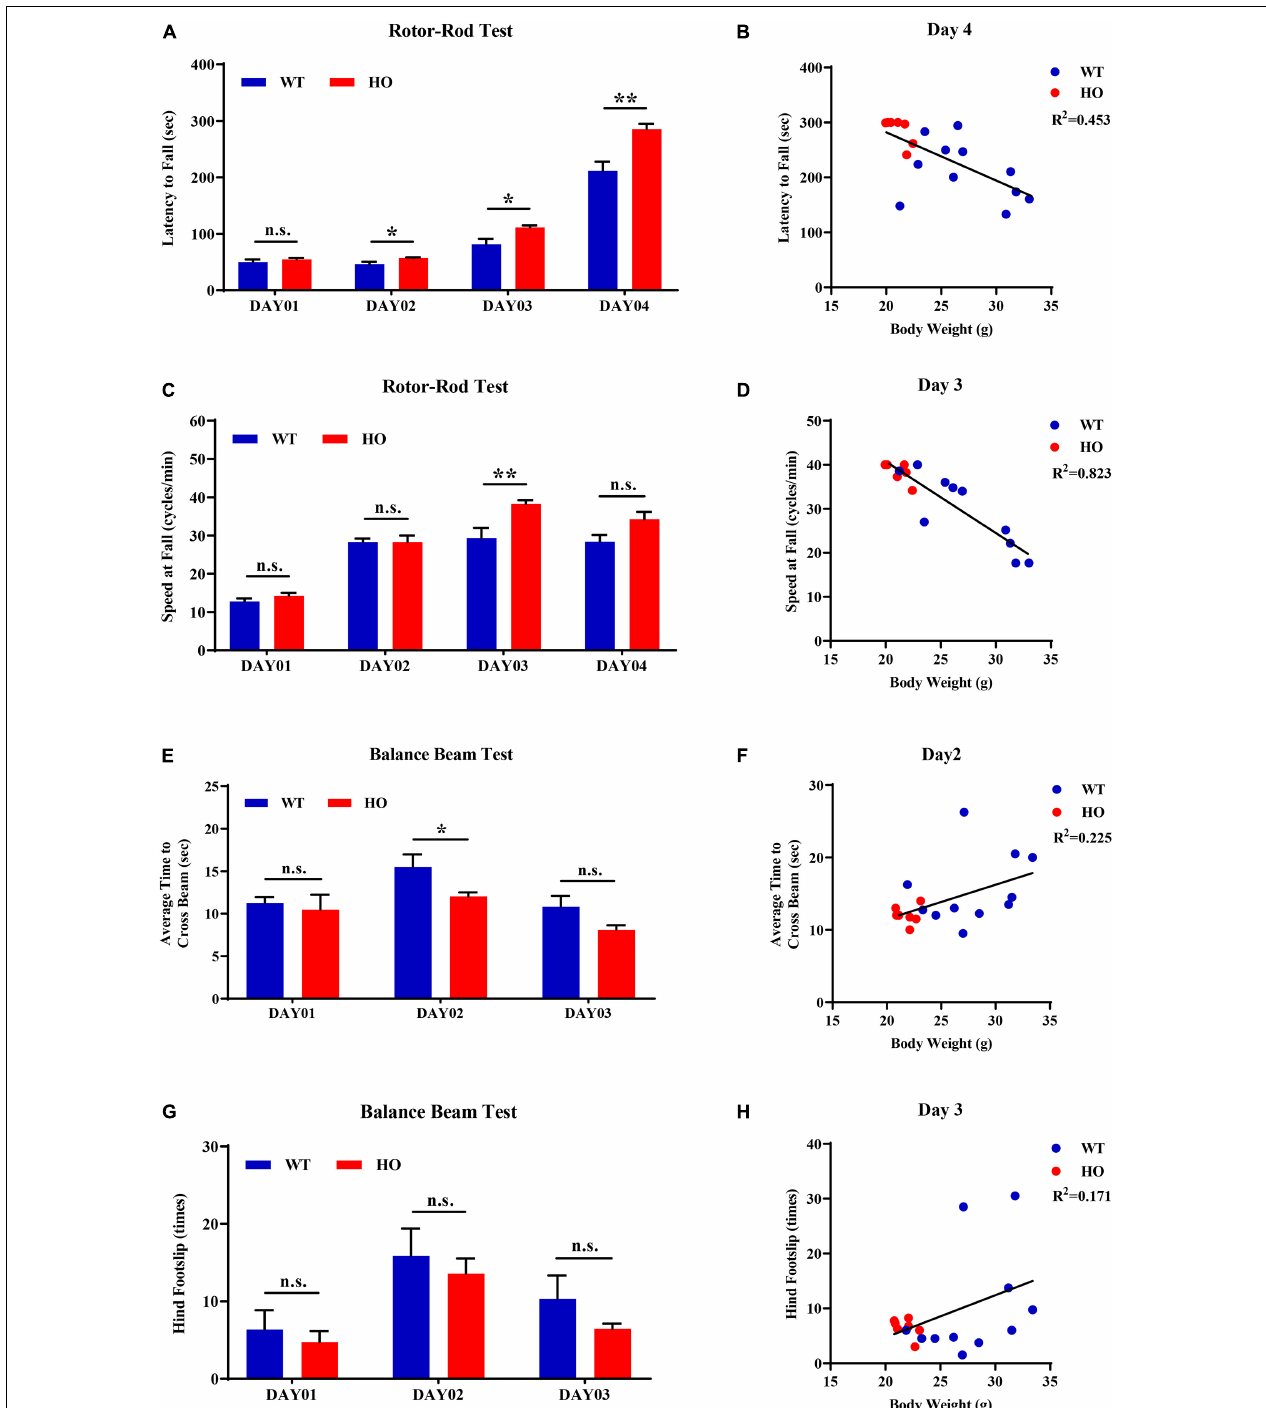
FIGURE 5 | Normal motor coordination abilities revealed by accelerating rotor-rod and narrowing balance beam tests in Slc20a2 -deficient mice. (A–D) Rotor-rod test for motor coordination: (A) time standing on the rotor-rod in each day trial. (B) Regression analysis for body weight and latency to fall in the day 04 trials of rotor-rod testing. (C) Falling speed of the rotor-rod in each day trial. (D) Regression analysis for body weight and falling speed in the day 03 trials of the rotor-rod test. (E–H) Balance beam test: (E) average time to cross the balance beam in each day trial. (F) Regression analysis for body weight and average time to cross the beam in the day 02 trials of balance beam test. (G) Hindfoot slips in each day trial. (H) Regression analysis for body weight and hindfoot slips in the day 03 trials of balance beam assessment. WT, wild Slc20a2 genotype; HE and HO, heterozygous and homozygous Slc20a2 gene trapping/knockout; * p < 0.05; ** p < 0.01; n.s., not statistically